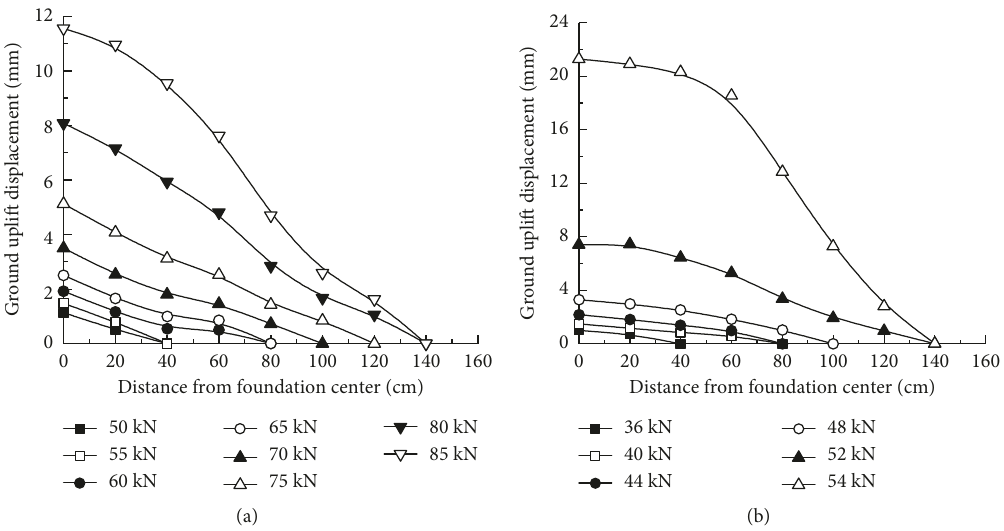
Figure 7: Ground displacement at uplift loading. (a) Test II and (b) Test IV.